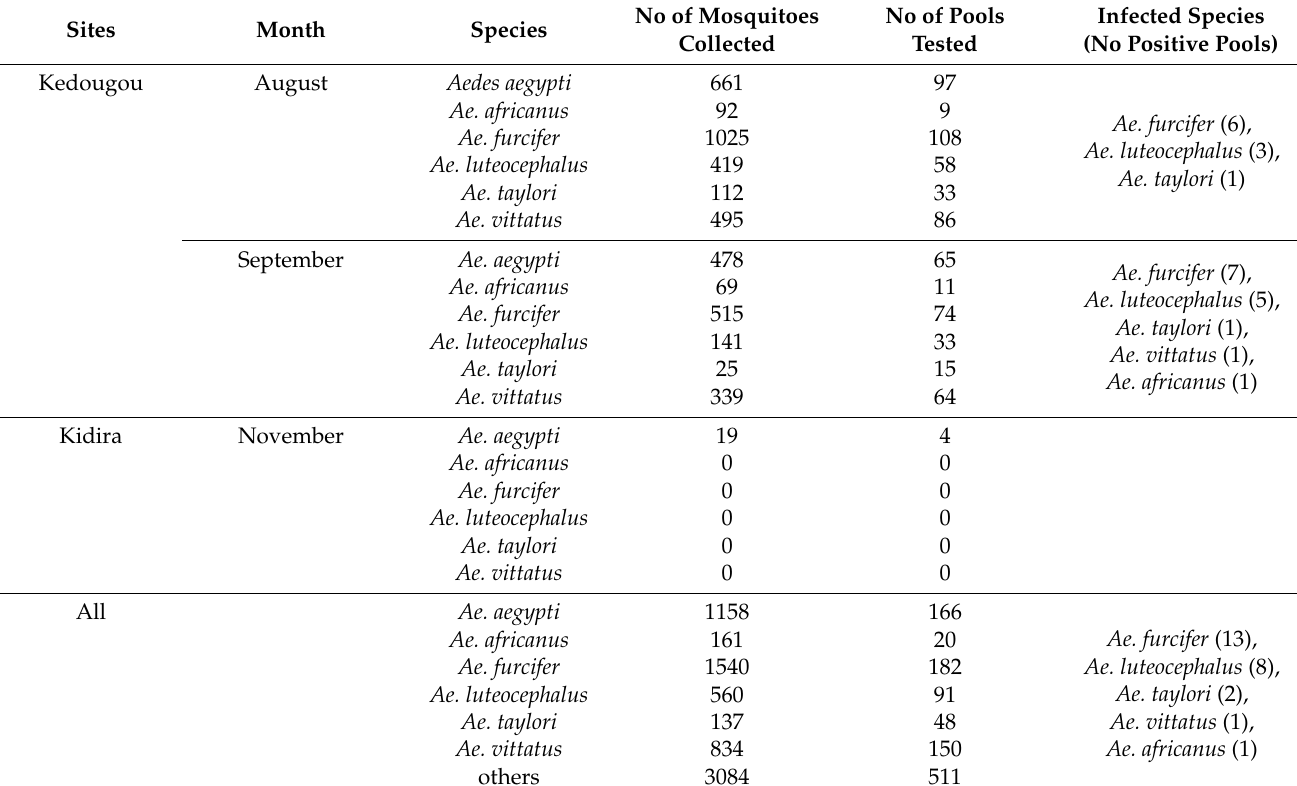
Table 3. Mosquitoes collected and yellow fever virus isolated Summary of the isolation attempts on mosquito pools trapped in eastern Senegal, August-September and November 2020.